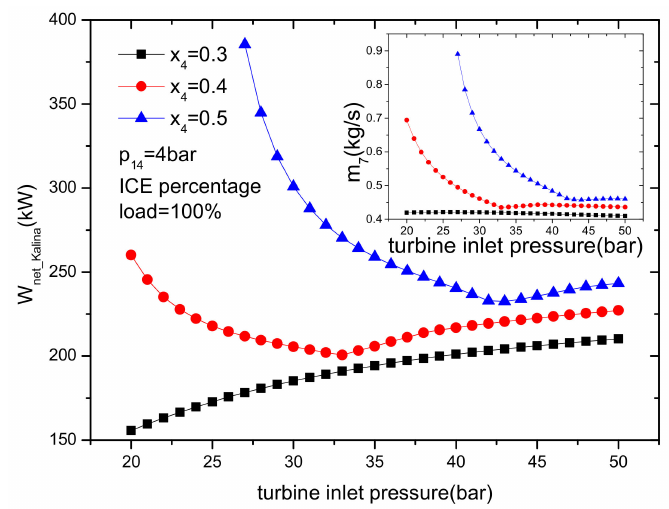
Figure 7. Effects of turbine inlet pressure on W net_Kalina .